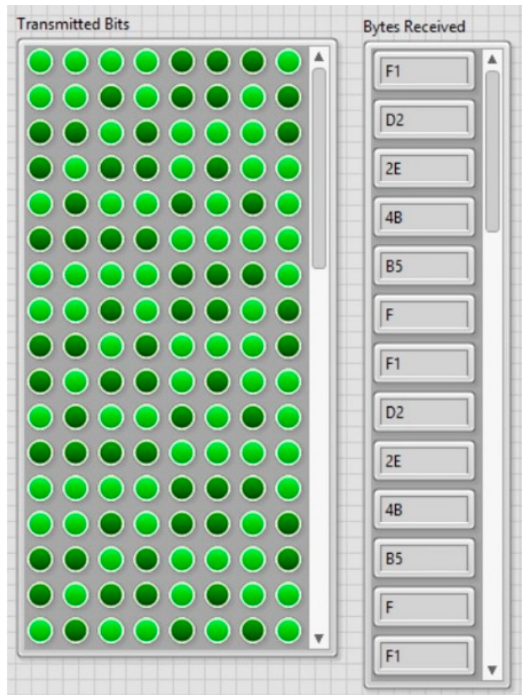
Figure 15. Two-dimensional ( 2D) array of 8 digital bits transmitted per row and its hexadecimal values of the received bytes.